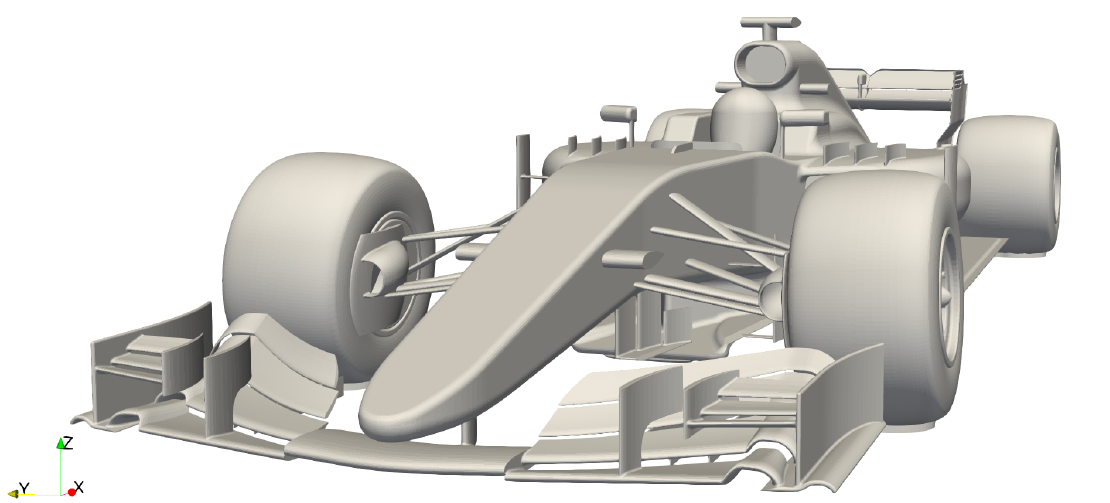
Figure 2. Generic view of the F1 car CAD model